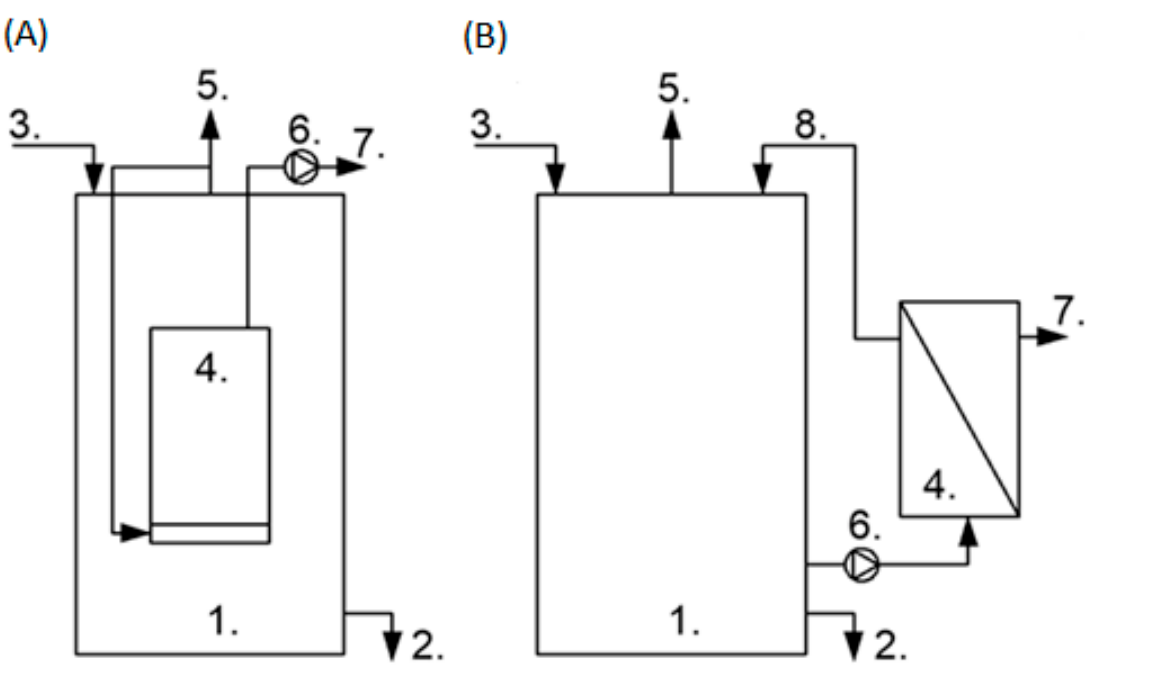
Figure 1. Submerged ( A ) and external ( B ) configuration of AnMBR; 1—anaerobic bioreactor, 2— excess sludge, 3—feed, 4—membrane module, 5—biogas, 6—pump, 7—permeate, 8—retentate.